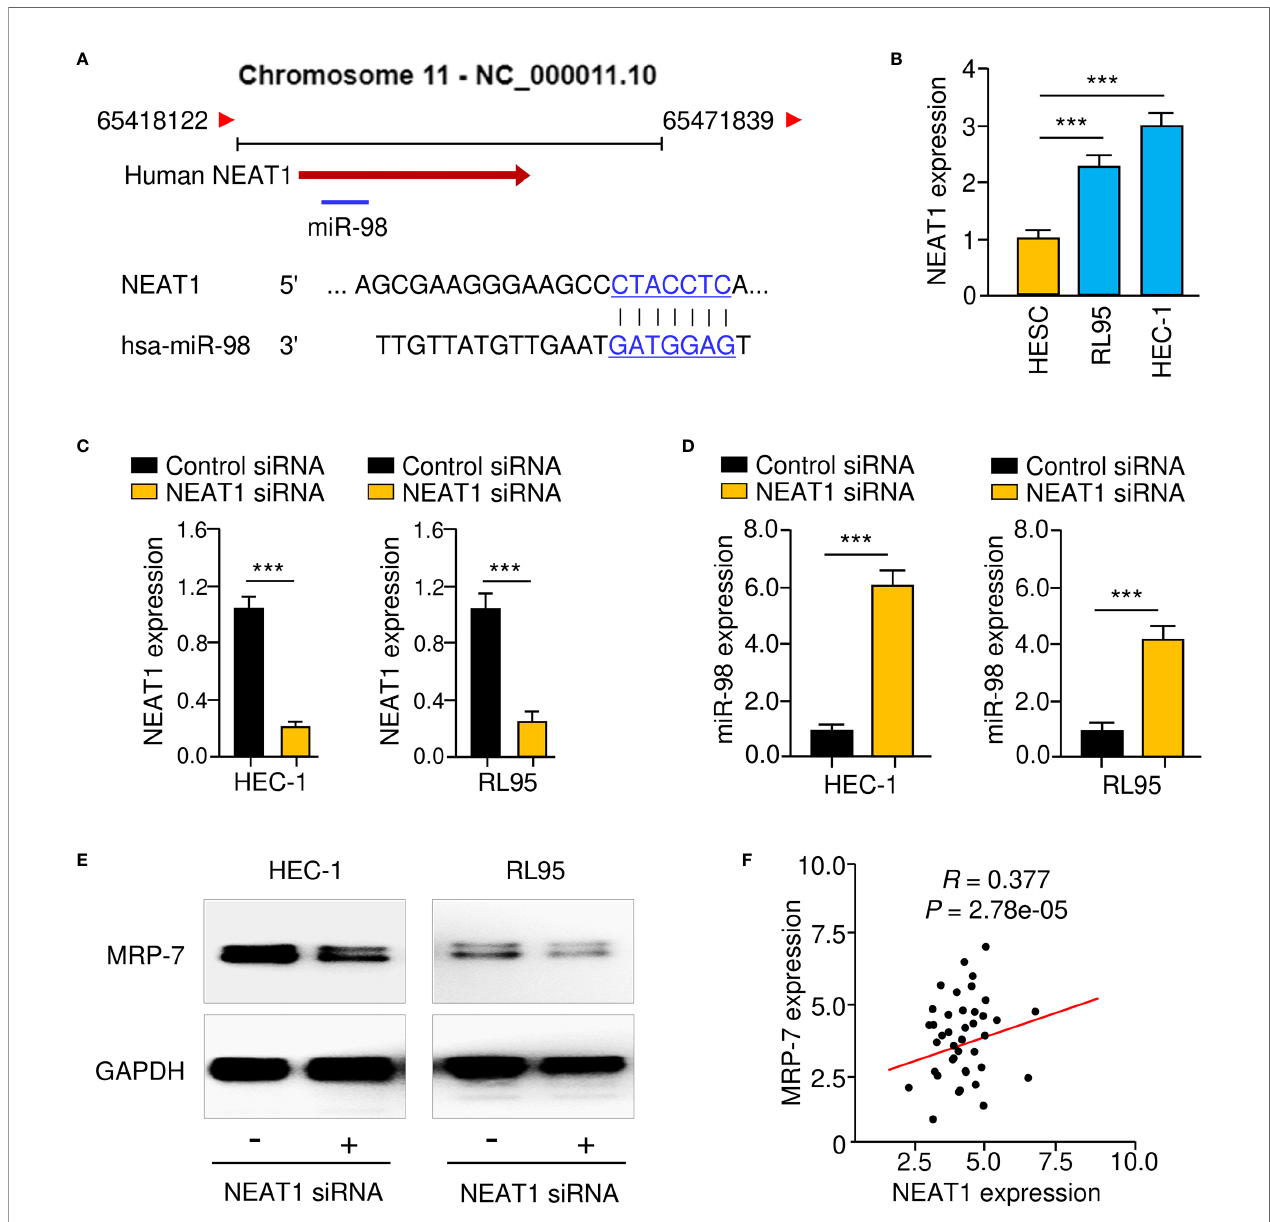
FIGURE 8 | LncRNA NEAT1 Functions as a Suppressor of MiR-98 in EC Cells. (A) In the lncRNA NEAT1 sequence, the anticipated miR-98 binding site was found. (B) The levels of NEAT1 in EC cell lines and HESC cells. (C, D) The expression of NEAT1 (C) and miR-98 (D) in EC cells transfected with NEAT1 siRNA or control siRNA. (E) Western blotting was used to assess MRP-7 protein expression in EC cells transfected with NEAT1 siRNA or control siRNA was examined using western blotting analysis. (F) The relationship between NEAT1 and MRP-7 expression in EC specimens. *** P <